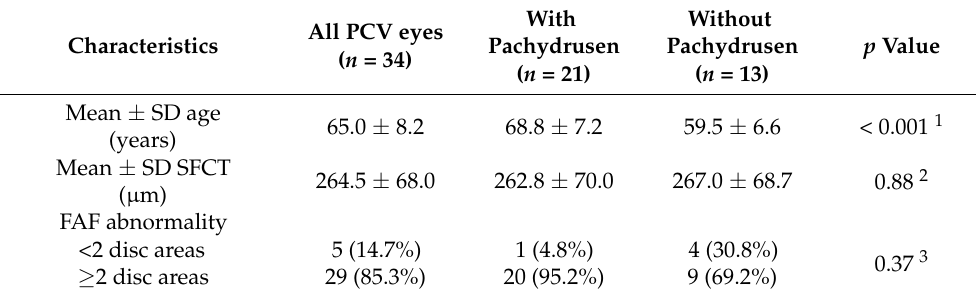
Table 2. Characteristics of PCV eyes with or without